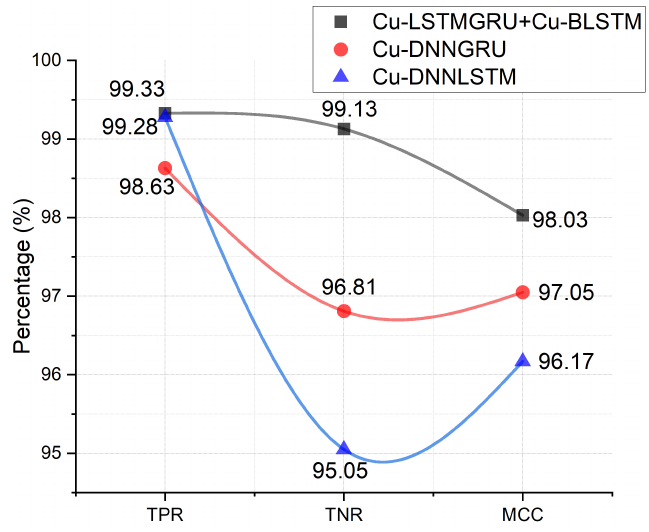
Figure 7. TPR, TNR, and